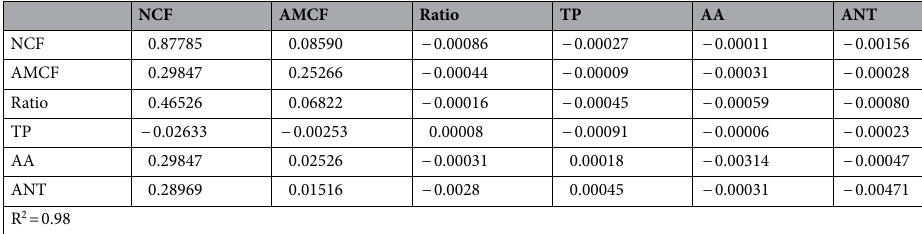
Table 2. Direct (on the main diagonal) and indirect (on the upper and lower diagonals) effects of the independent variables on the mass of commercial fruits in 10 populations of Fragaria × ananassa Dusch. AA ascorbic acid (mg ascorbic acid 100 g −1 pulp), and ANT anthocyanins (mg cyanidin-3-glucoside 100 g −1